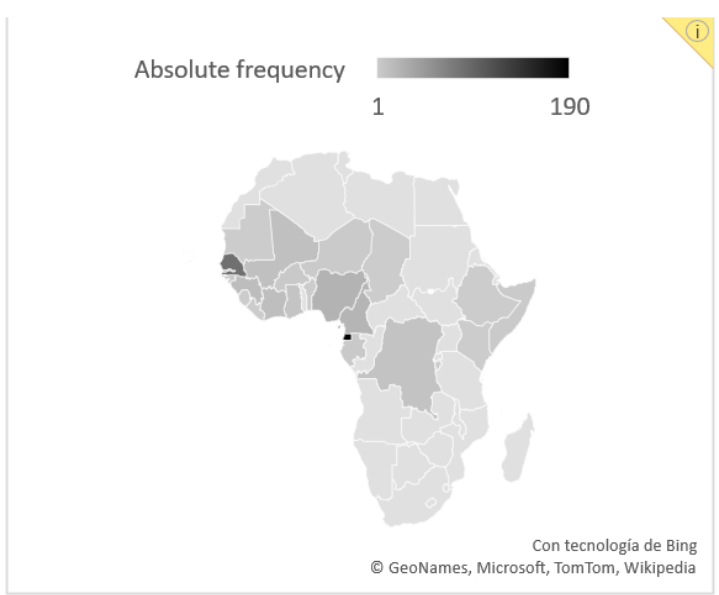
Figure 2. Country of origin of individuals in overall cohort ( n = 440) by absolute frequency.